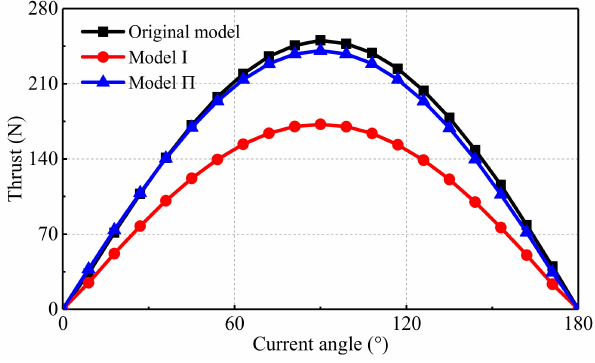
Figure 20. Thrust versus current angle at the same current